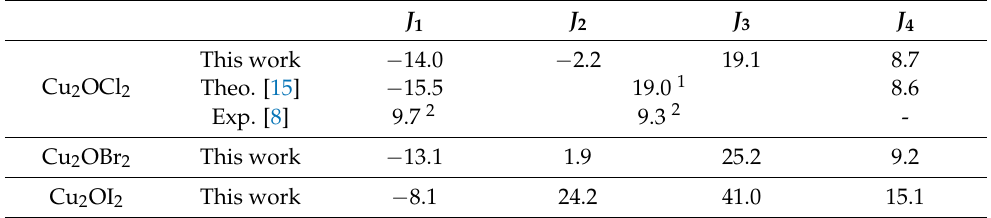
Table 3. Magnetic exchange interactions (in meV) calculated at the PBE0 on-site level for the Cu 2 OX 2 compounds (X = Cl, Br, I). The available experimental and theoretical data are given for comparison. J > 0 indicates an AFM coupling, and J < 0 indicates an FM coupling. J